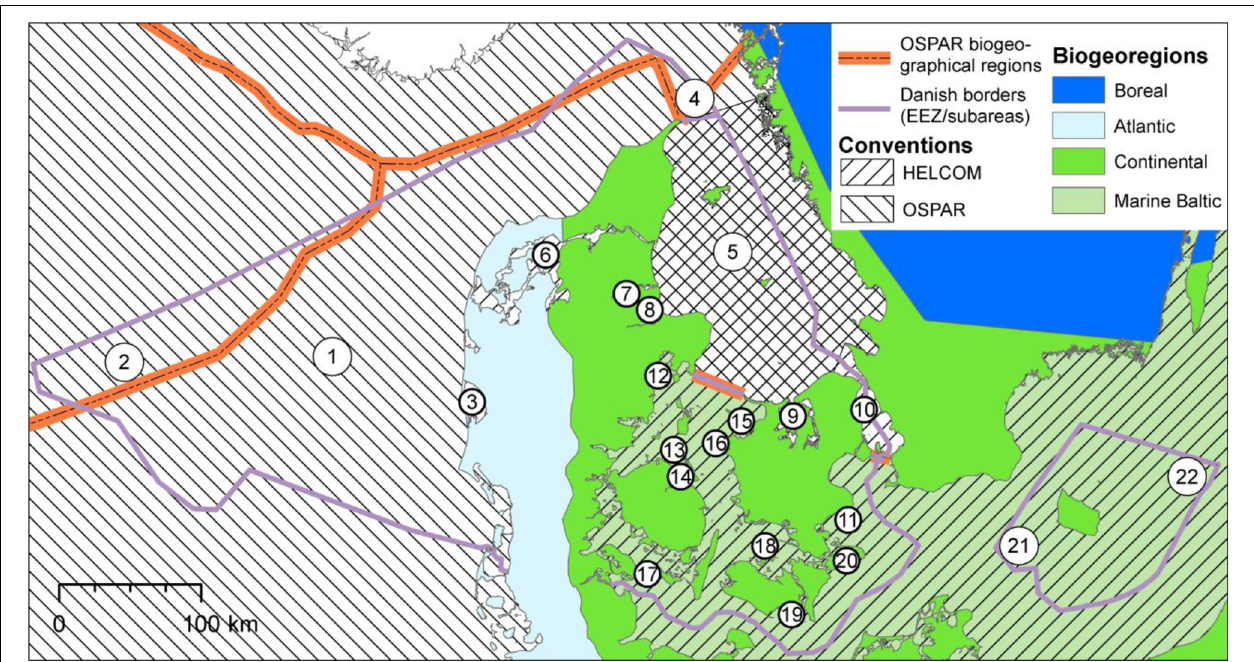
FIGURE 1 | Map of Danish marine waters. The borders indicated in the map represent the current MSFD boundary between the North Sea region and the Baltic Sea region, relevant OSPAR boundaries, relevant HELCOM boundaries as well as relevant Habitats Directive boundaries for